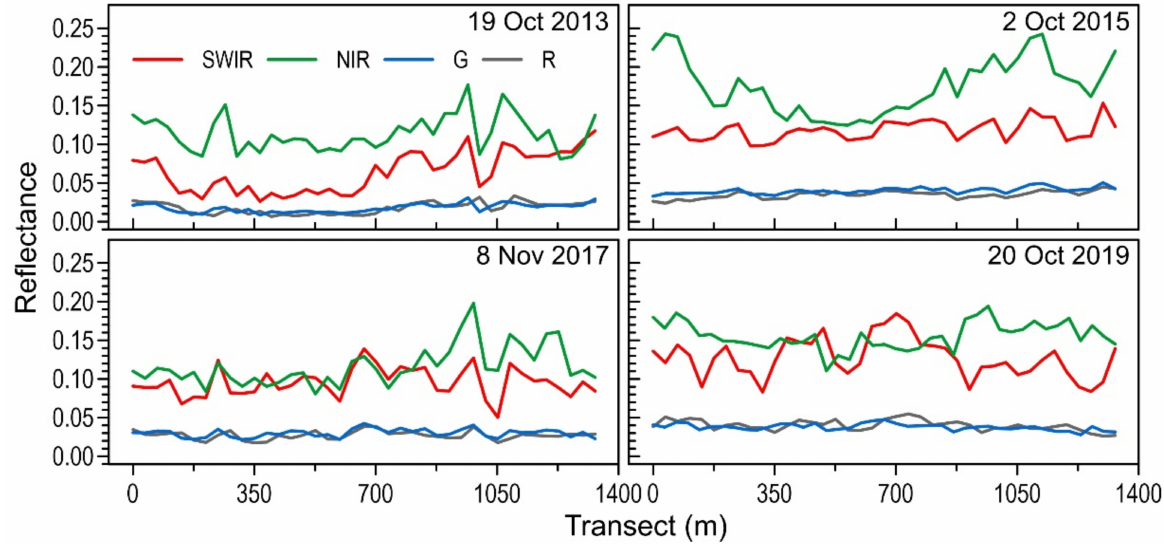
Figure 3. Reflectance of SWIR, NIR, and G wavebands along the A–B transect for 2013, 2015, 2017, and